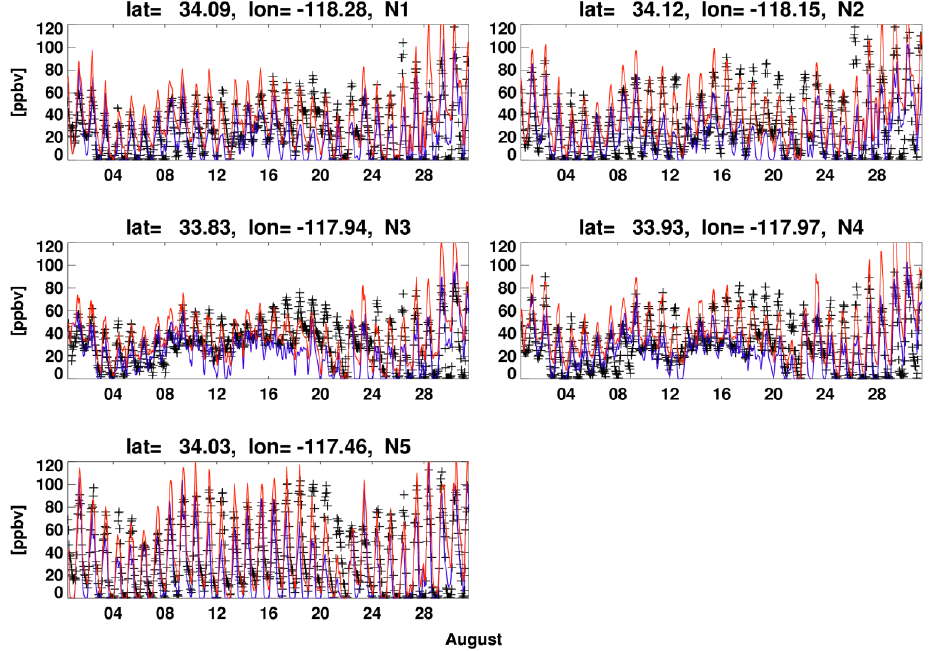
Fig. 6. Surface O 3 concentrations at EPA AQS stations (black crosses), corresponding baseline CMAQ simulations with baseline emissions, BASE2009 (blue), and CMAQ simulations with GOME-2-adjusted NO x emissions, GOME2009 (red) at the five station grids (see the right panel of Fig. 3, 1: Los Angeles, 2: South Pasadena, 3: Anaheim, 4: La Habra, and 5: Riverside) in August 2009.